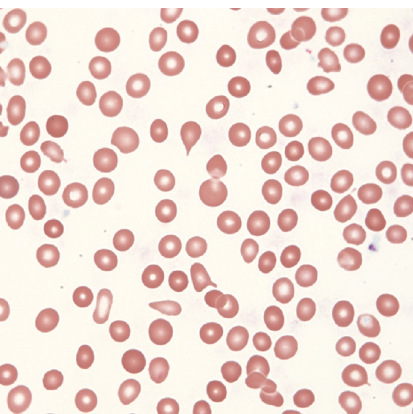
Figure 1: Peripheral blood smear with pancytopenia and teardrop red blood cells (Wright 400x).